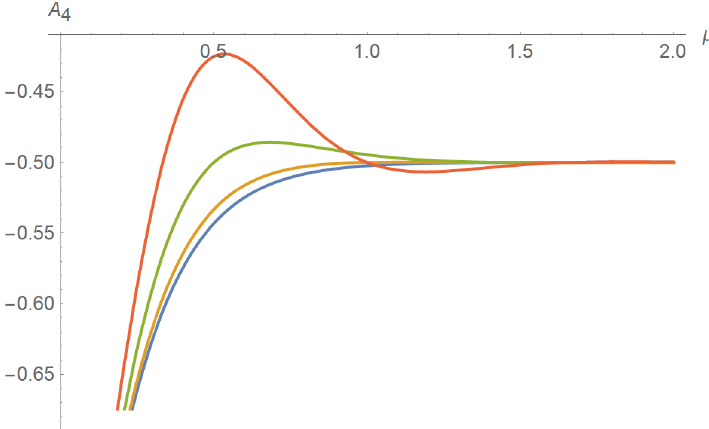
, 1 , and 0 (lower blue curve). Note that A 4 = − 1 2 4